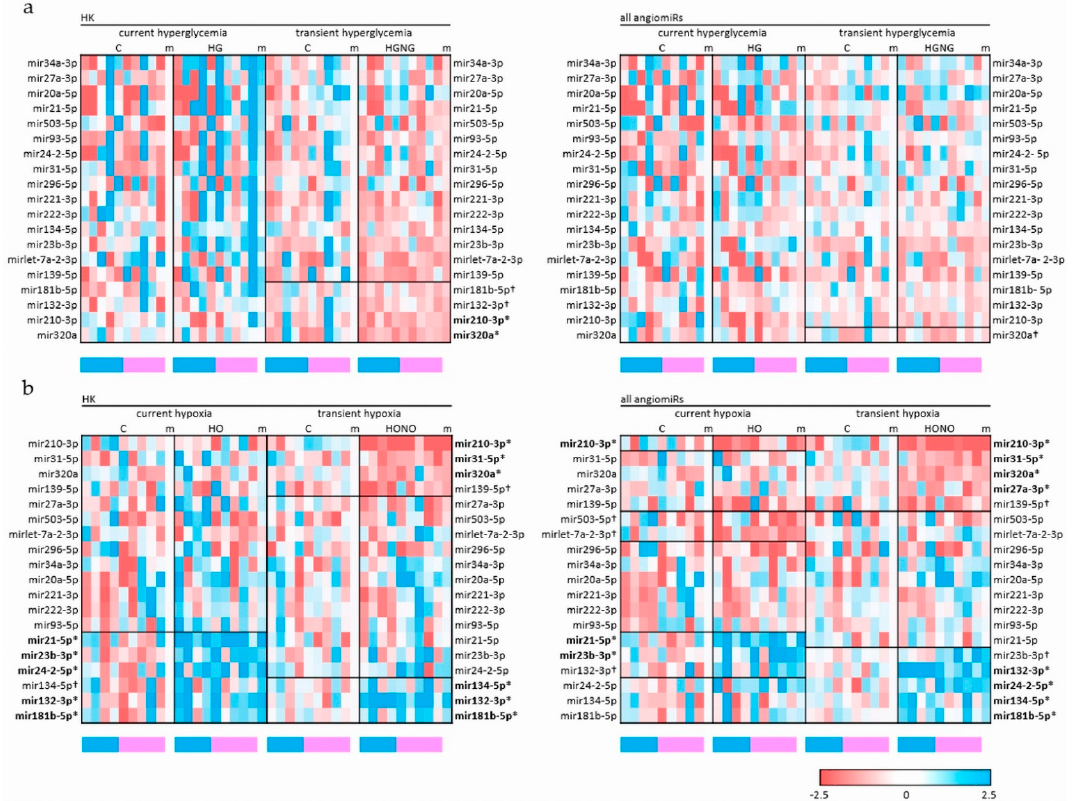
Figure 3. Heatmap illustrating the effect of current and transient treatments on angiomiR expression. The changes in an- giomiR expression under current and transient hyperglycemia (HG; HGNG) vs. control conditions ( a ) and changes in angiomiR expression under current and transient hypoxia (HO; HONO) vs. control conditions ( b ). ‘HK‘ indicates that miRNAs were normalized to the geometric mean of five housekeepers; ‘all angiomiRs‘ indicates that miRNAs were nor- malized to the geometric mean of all angiomiRs. Downregulation vs. respective control condition is highlighted by red color, upregulation by blue color, and unchanged expression by white color. The columns entitled with ‘m’ represent the mean value of the condition. * indicates that the angiomiR is significantly different from control condition ( p < 0.05), † indicates that angiomiR differs from control conditions by trend ( p < 0.1). Groups of angiomiRs that are changed signifi- cantly or per trend are framed with a line. miRNAs are printed in bold if they are significantly changed by any condition (current or transient) in the respective heatmap. The blue (male) and pink (female) bars underneath the heatmaps indicate the sex of the fpEC donor. The respective color codes for up- and downregulation are given in the lower right corner. Heatmaps were generated using MS Excel.